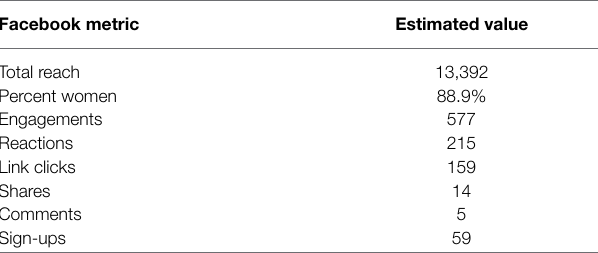
TABLE 3 | Facebook ad reach